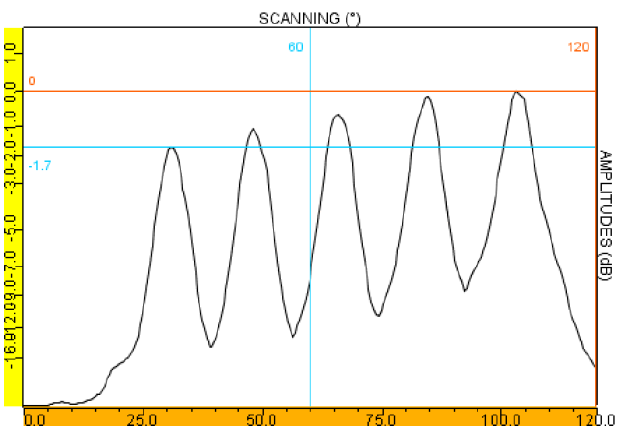
Fig. 7. Amplitude echodynamic curve.